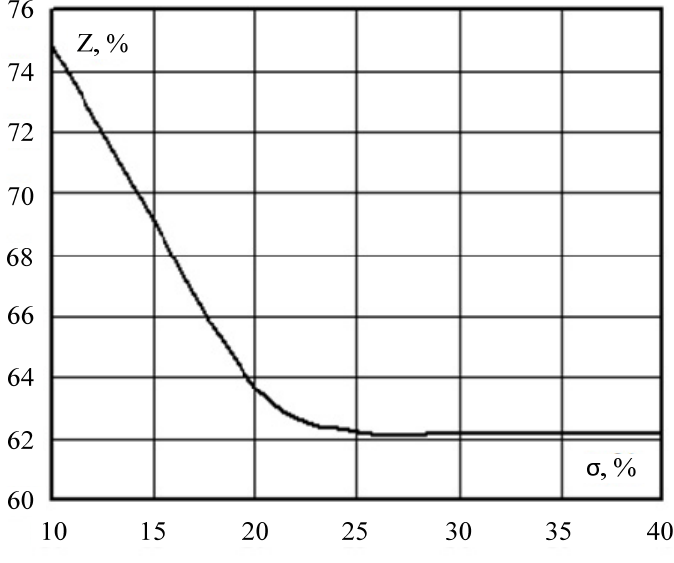
Figure 10. Dependence of the stability margin on the standard deviation of the load capacities.